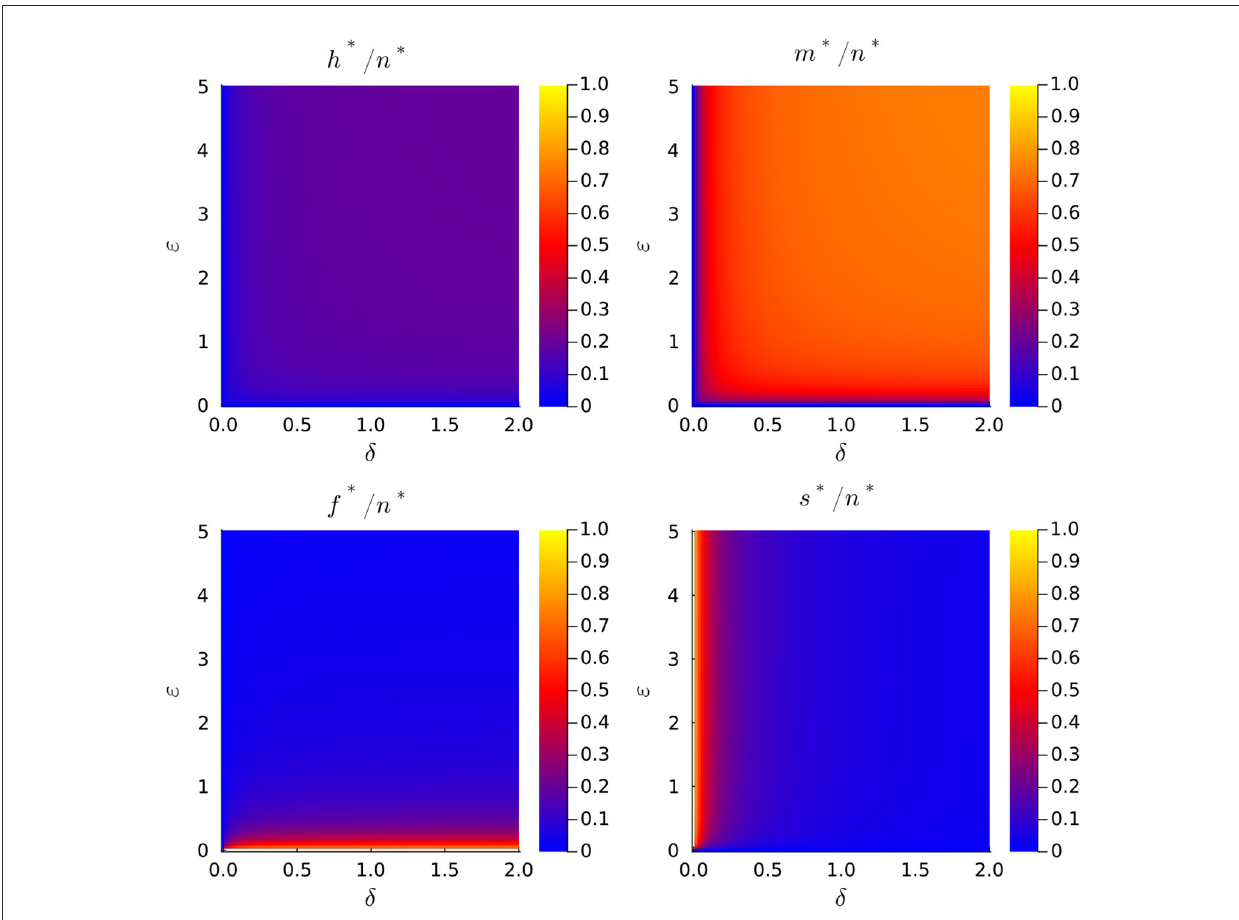
FIGURE3 Dependence of the normalized total mitochondrial volume density, n ∗ , on the normalized fission rate, γ , for different values of the normalized aging rate, β .